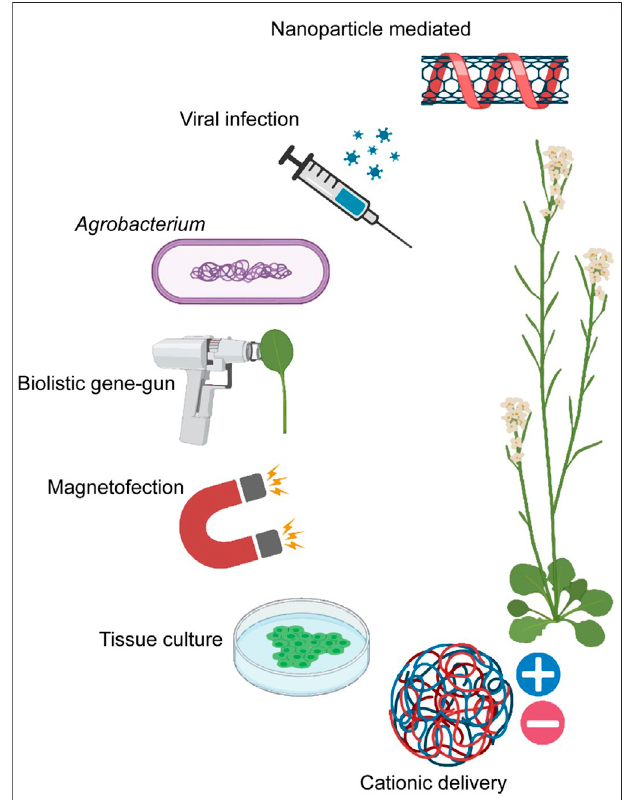
FIGURE 1 | The current modes of cargo delivery that can be employed for CRISPR Cas reagent delivery in planta : nanoparticle-mediated (Lew et al., 2020c), viral infection (Ma et al., 2020), Agrobacterium (Zhang et al., 2019c), biolisticgene-gun(Milleretal.,2021),magnetofection(Zhaoetal.,2017), tissueculture(NastiandVoytas,2021)andcationicdelivery(Duanetal.,2021) (Created with